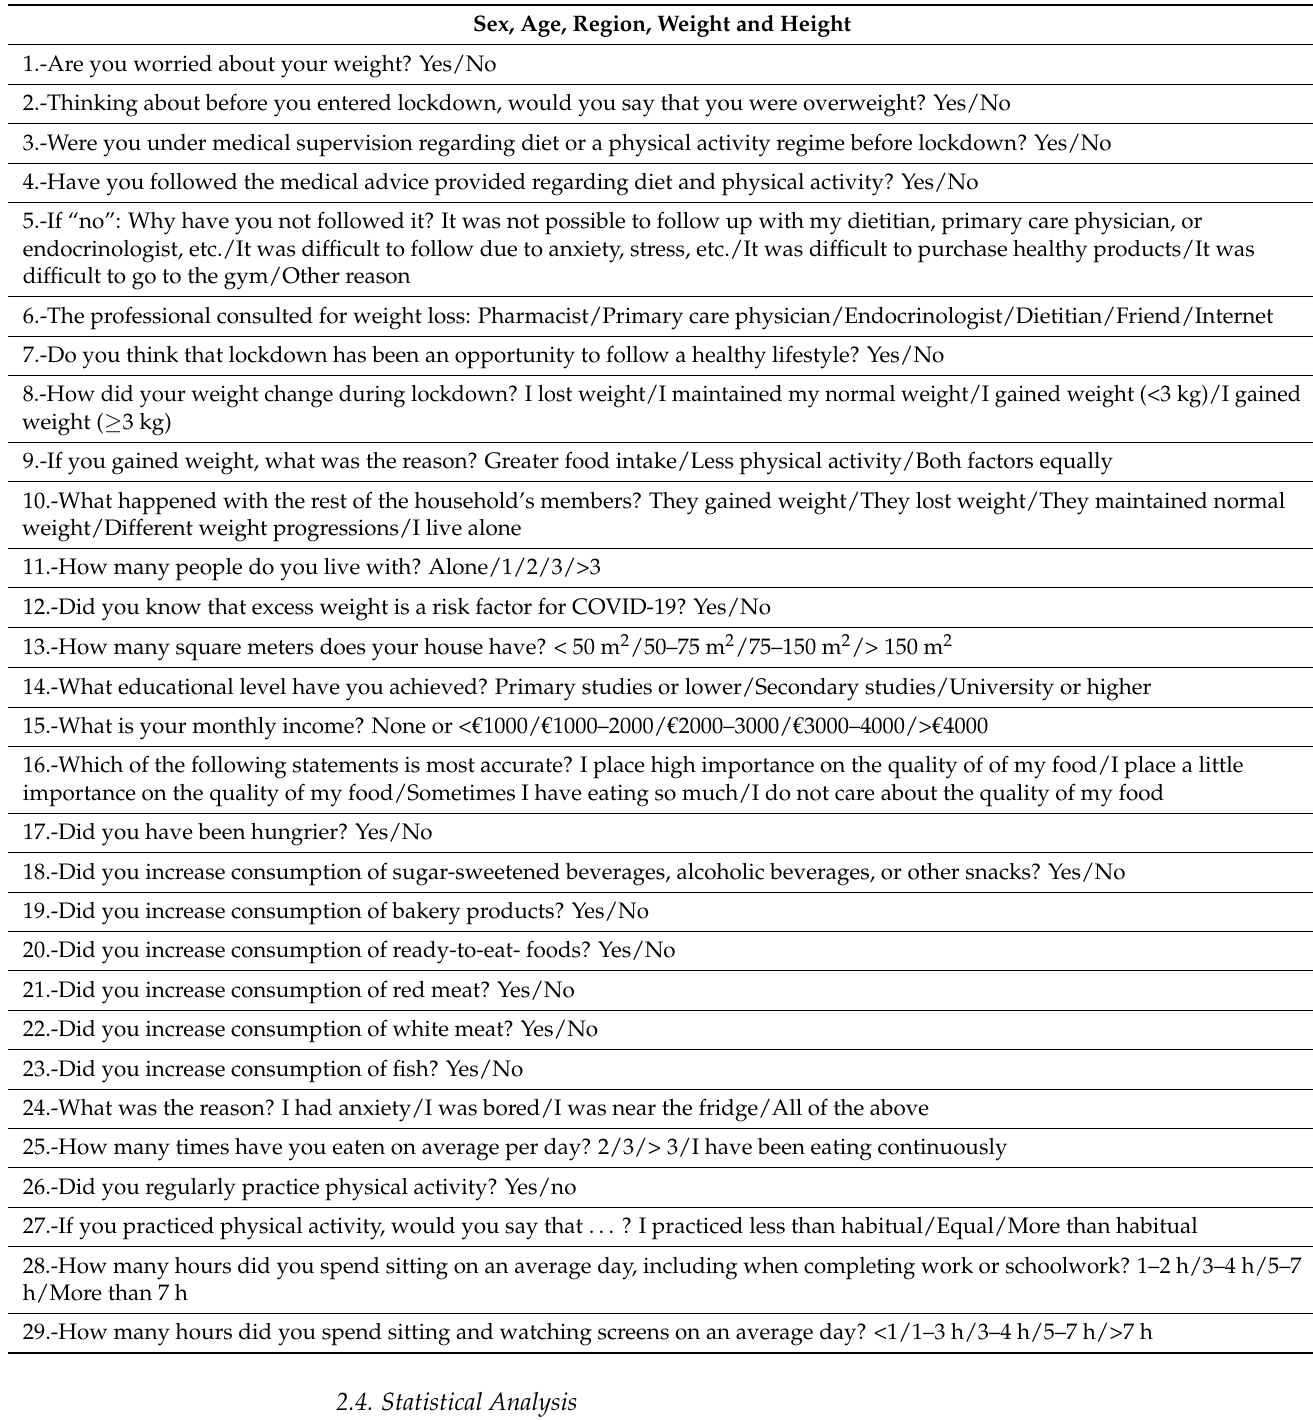
Table 1. The full computer-assisted telephone interviewing